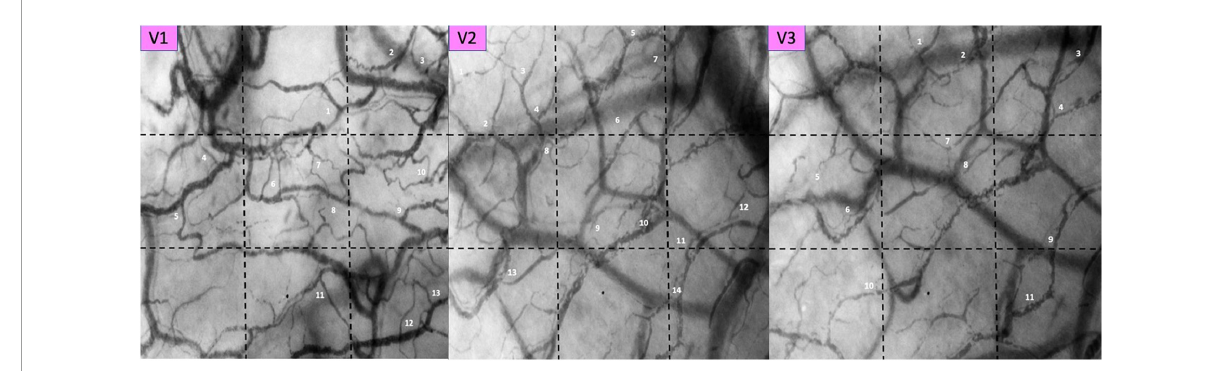
FIGURE2 Pictures of each selected video. Post Capillaries Venules (PCV) units are identified by sequential numbers and associated to the space-time diagrams analyses in Figure 3